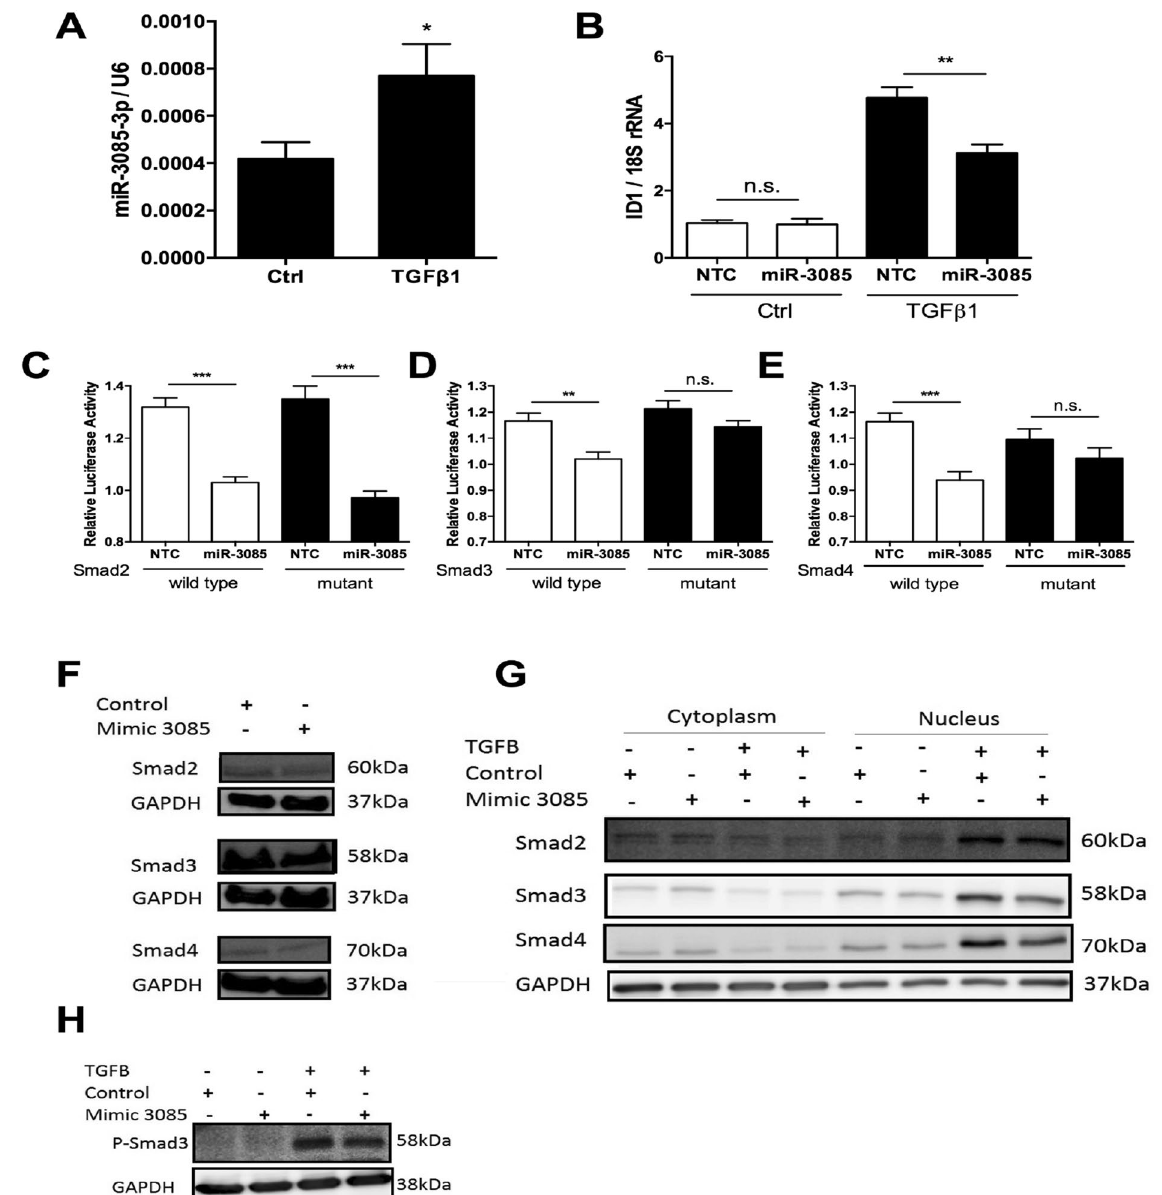
Figure 5. TGFβ induces miR-3085-3p which represses Smad signaling. Primary human articular chondrocytes were cultured in micromass culture for 48 h. ( A ) cells were then treated with TGFβ1 (4 ng/ml), or control for 24 h; miR-3085-3p was measured by qRT-PCR. ( B ) Primary human articular chondrocytes were grown in monolayer culture and transiently transfected with miR-3085-3p or a non-targeting control (NTC) for 24 h prior to stimulation with TGFβ1 (4 ng/ml), or control for 6 h; ID1 was measured by qRT-PCR. ( C – E ) SW1353 cells were transiently transfected with the ( C ) Smad2, ( D ) Smad3, ( E ) Smad4. 3 ′ UTR subcloned into the pmirGLO vector (wild-type) or a construct with miR-3085-3p seed sites mutated (mutant) with miR-3085-3p mimic or non-targeting control (NTC) for 24 h. Firefly luciferase relative light units were normalised to Renilla relative light units to give overall relative light units. Mean + /− SEM, n = 3; Student’s t-test; * p < 0.05; ** p < 0.01; *** p < 0.001. ( F ) SW1353 cells were transiently transfected with miR-3085-3p or a non-targeting control for 48 h prior to western blot analysis. ( G ) SW1353 cells were grown in monolayer culture and transiently transfected with miR-3085-3p or a non-targeting control for 48 h prior to stimulation with TGFβ1 (4 ng/ml), or control for 2 h, fractionation and western blot analysis. ( H ) SW1353 cells were grown in monolayer culture and transiently transfected with miR-3085-3p or a non-targeting control for 48 h prior to stimulation with TGFβ1 (4 ng/ml), or control for 2 h and western blot analysis. Full-length blots are presented in Supplementary